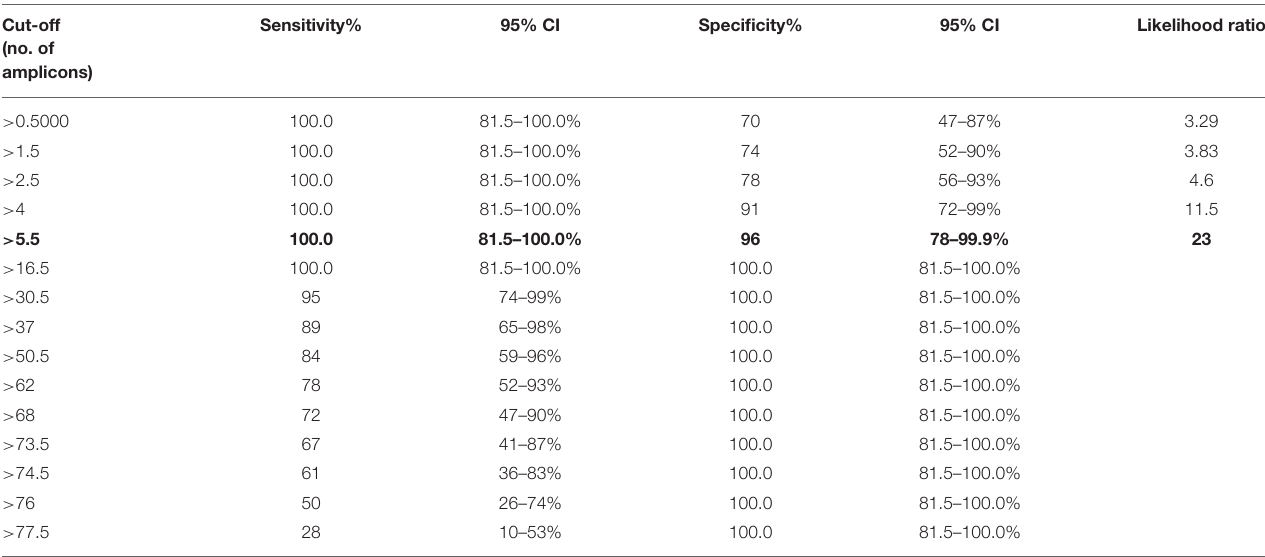
TABLE 1 | ROC analyses thresholds and